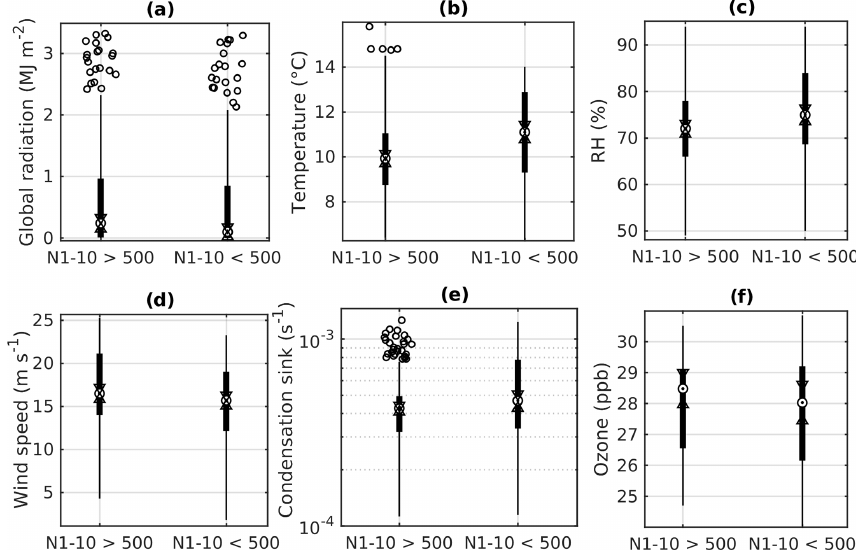
Figure 12. Box plots for different meteorological variables in marine air when N 1–10 is (a) over 500 (b) and under 500. The circles are the median concentrations, notches (triangles) show the 95% confidence interval of the medians, black boxes mark the 25th and 75th percentiles, the whiskers cover approximately 99.3% of the data, and the rest of the points are outside this